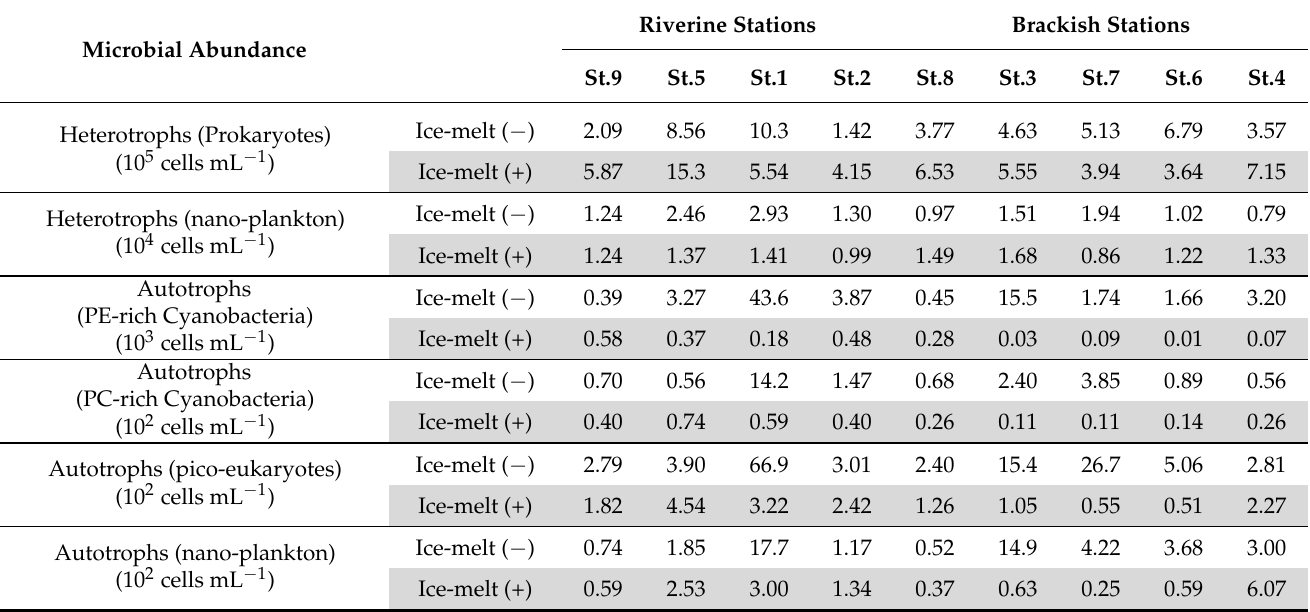
Table 3. Microbial cell abundances determined in May (Ice-melt ( − )) and July (Ice-melt (+)) by flow cytometry in the Pasvik River.